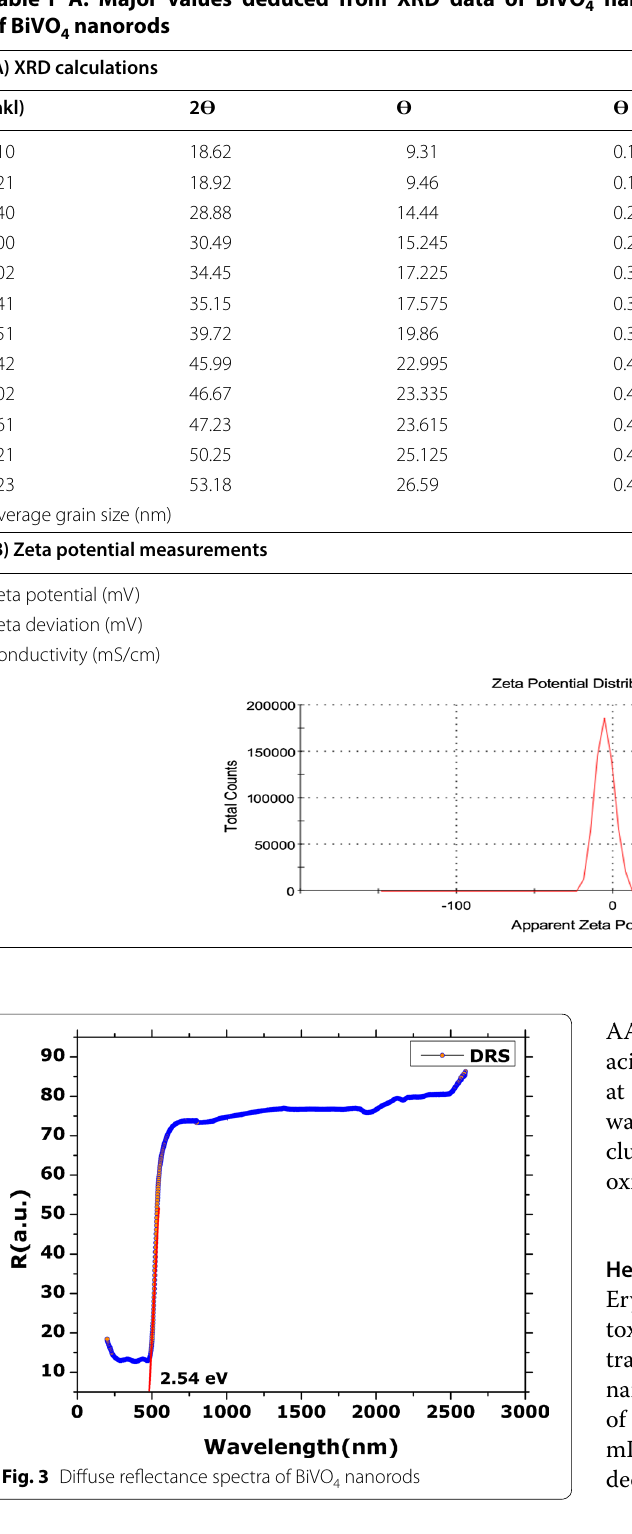
nanoparticles from H. thebaica ; B: Zeta potential report 4